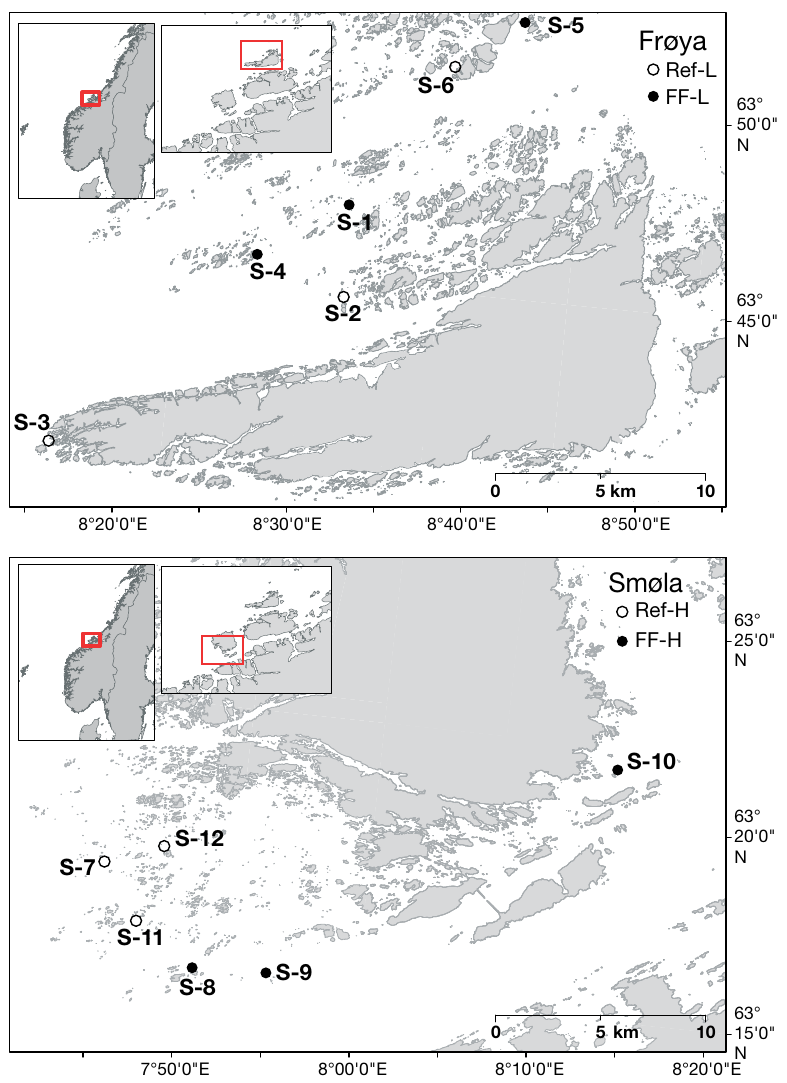
Fig. 1. Location of sampling sites in the 2 archipelagic study areas: Frøya and Smøla, Norway. Laminaria hyperborea kelp canopy plants were collected along transects at 5 m depth at 3 reference sites (Ref) and 3 salmonid fish farm sites (FF) in each area. FF-L and FF-H denote fish farms with low and high effluent loads at the time of sampling,